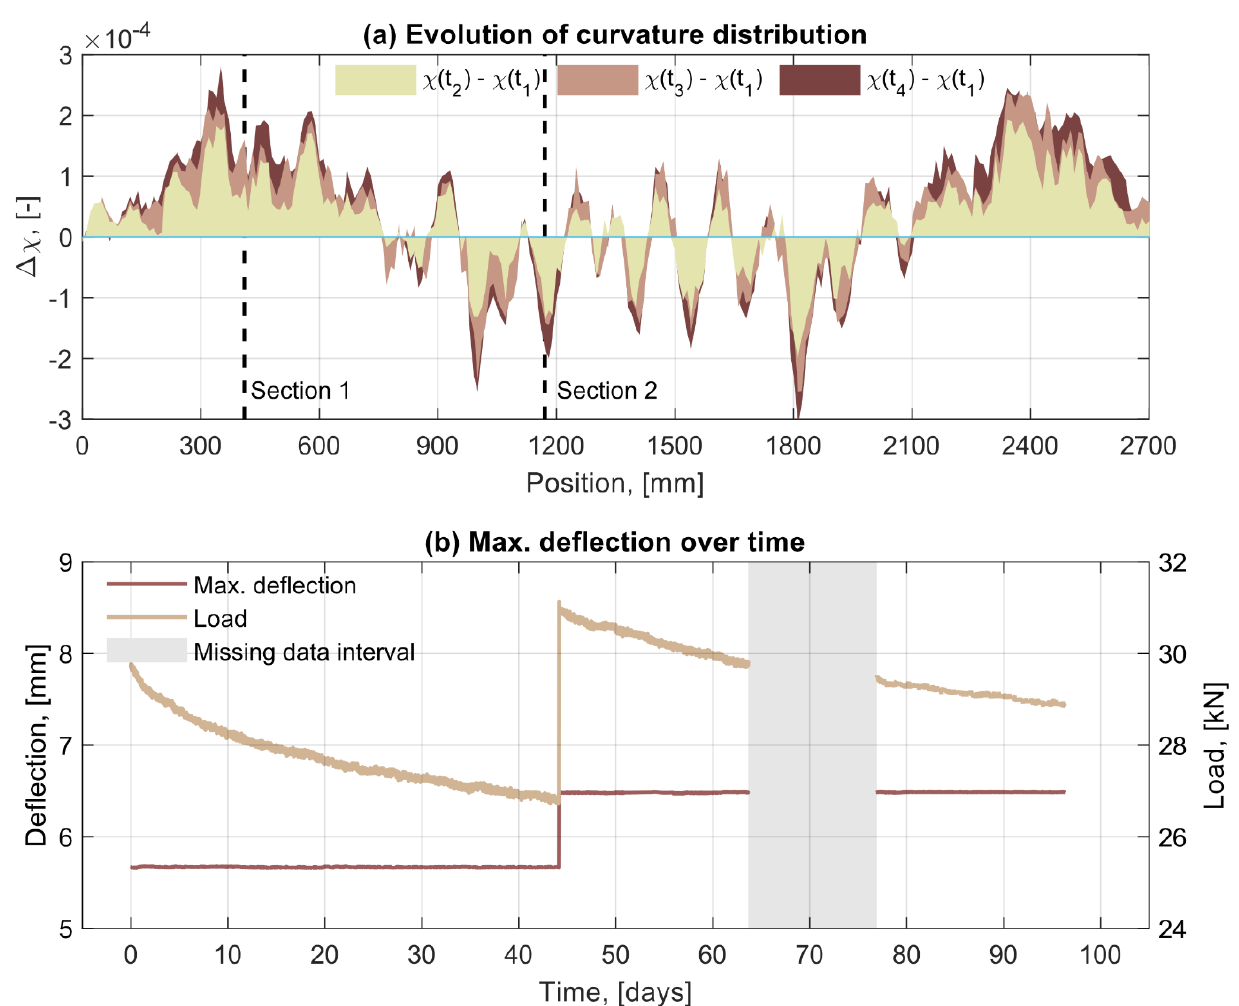
Figure 6. ( a ) Distribution of curvature increment along the beam for the instants t 2 , t 3 and t 4 with respect to the initial instant t 1 ; ( b ) evolution of the maximum deflection in beam 5 calculated from the DOFS strain measurements together with the corresponding evolution of applied load.